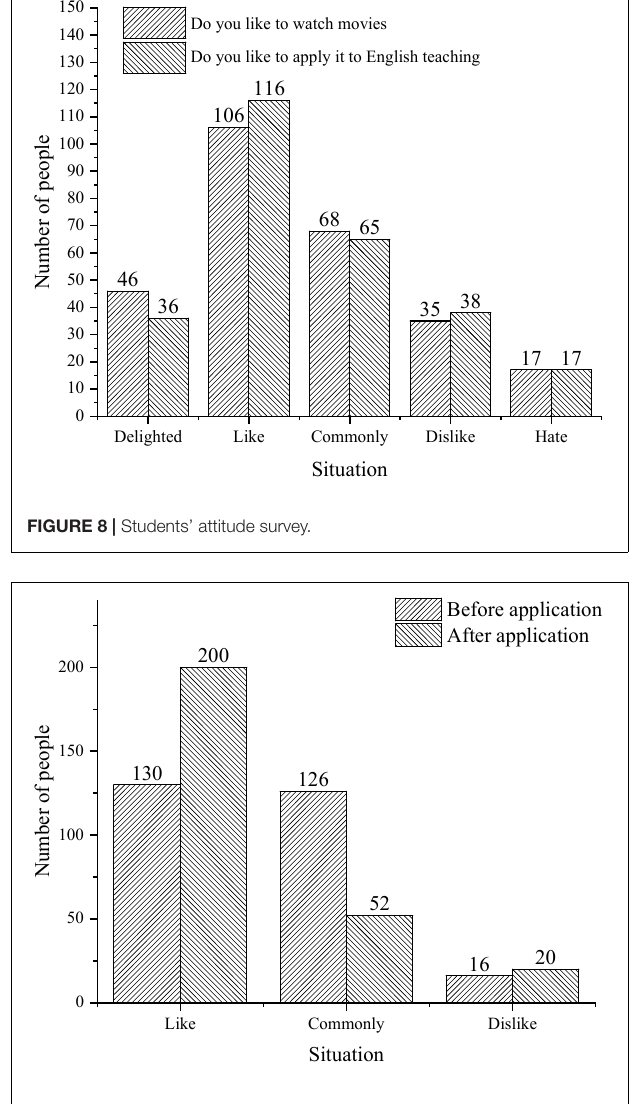
FIGURE 9 | Comparison of students’ attitudes before and after the application of film teaching.